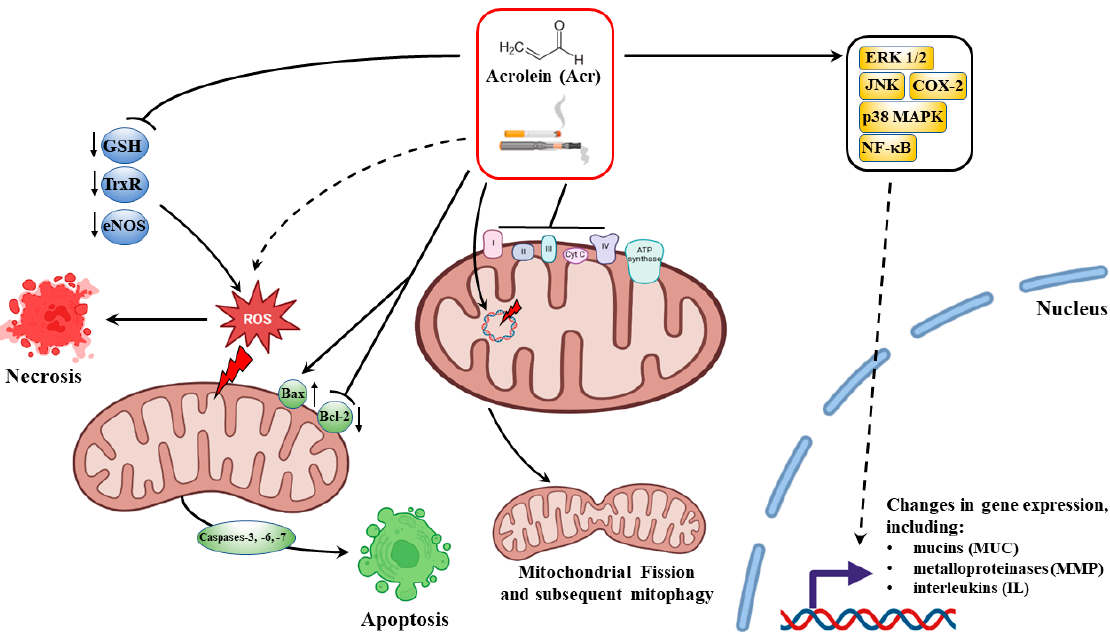
Figure 1. Molecular mechanisms of the cytotoxic effect of acrolein (Acr) in smokers are realized on several levels of cell functioning. Acrolein, through direct interaction with antioxidant enzymes (primarily GSH), disrupts redox homeostasis and contributes to the generation of ROS and the necrosis/apoptosis dependent on them. The negative effect of acrolein on mitochondrial biogenesis is also of great importance to damage to lung and respiratory system cells, i.e., inhibition of the activity of respiratory chain complexes and change of metabolism to glycolysis, mtDNA damage, mitochondrial fission, which is followed by autophagy/mitophagy. Due to the effect of acrolein on cell signaling pathways and direct interaction with numerous transcription factors (the main target of NF-kB), the aldehyde has strong immunomodulatory properties (regulation of pro-inflammatory cytokines). In addition, through the control of mucin (MUC) and metalloproteinase (MMP) gene expression, acrolein is involved in mucus hypersecretion and tissue modification and degradation in lung diseases.